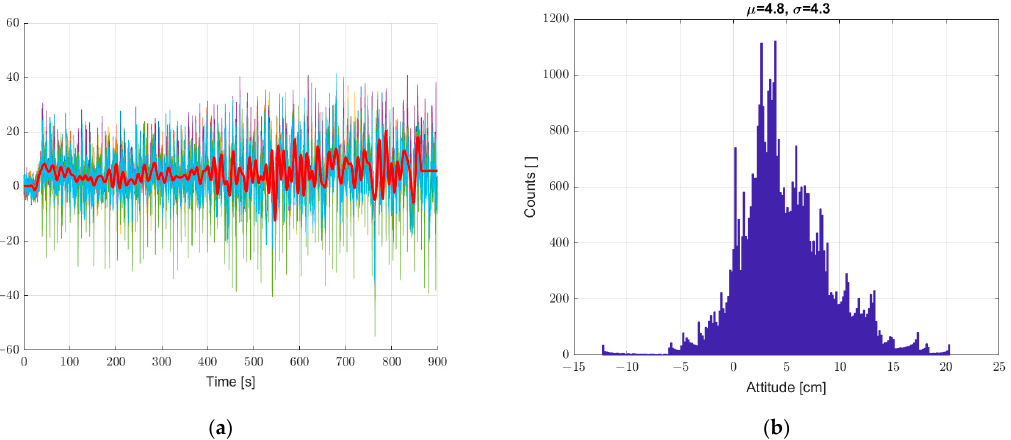
Figure 15. ( a ) Bold graph calculated from data averaged and filtered with an IIR low-pass filter, plotted over time with 6 + 1, and ( b ) histogram. Static measurements—sensor array at standstill, with additional variable crosswind gusts.